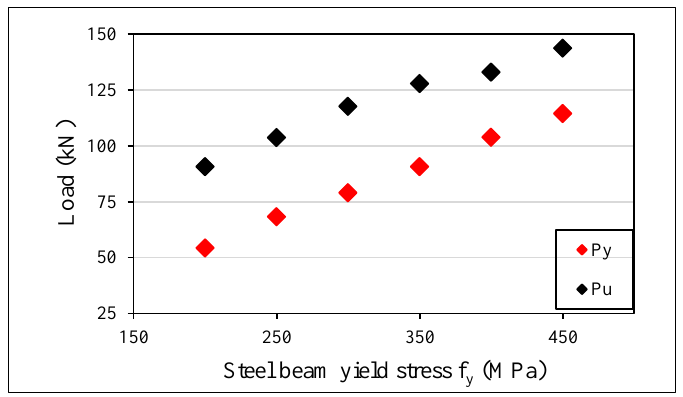
Figure 22. Yield, ultimate load-steel beam yield stress relationship